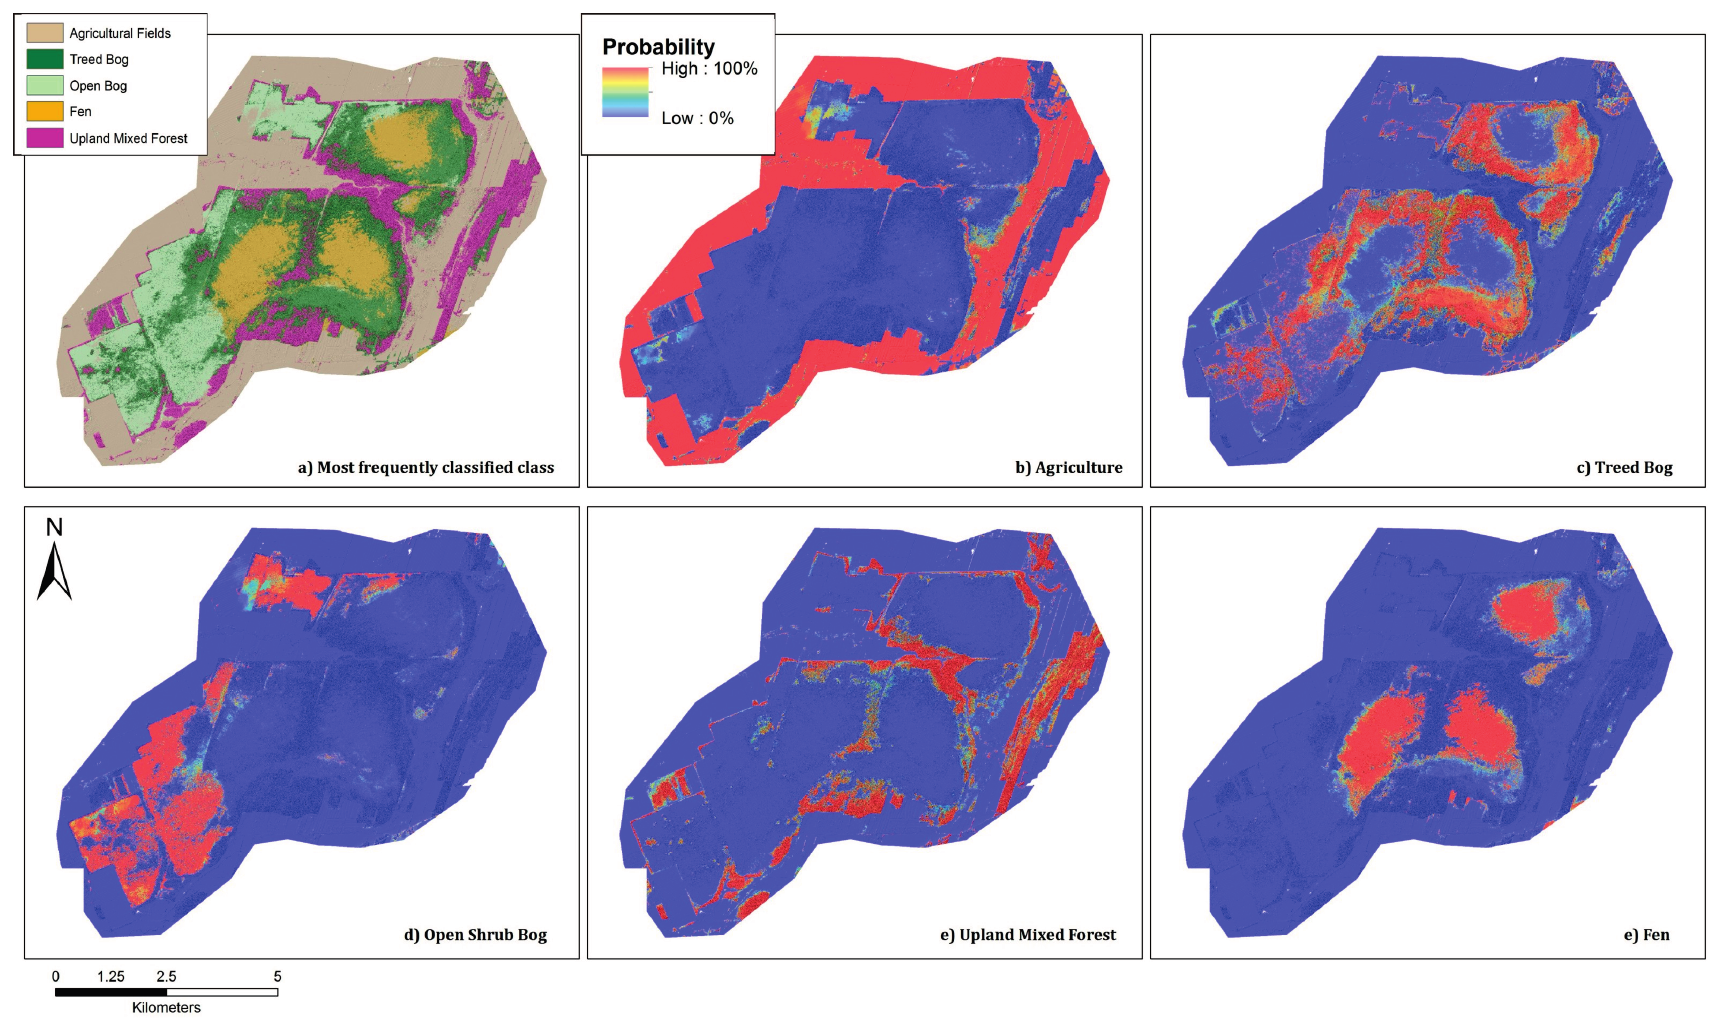
Figure 6. Probability analysis indicating the percentage of times each grid cell was classified as a particular class in 25 iterations of the classification with Uncorrelated Important Variables . A random selection of 100 of the 500 sample points was reserved each time for independent validation. ( a ) Most frequently classified. ( b – f ) Percentage of times each pixel was classified as a specific